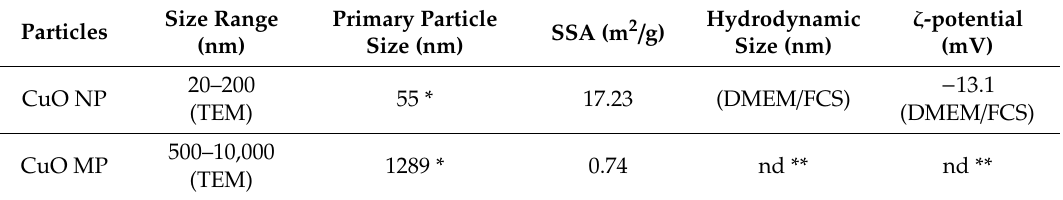
Table 1. Characterization of the applied CuO particles (summarized from reference